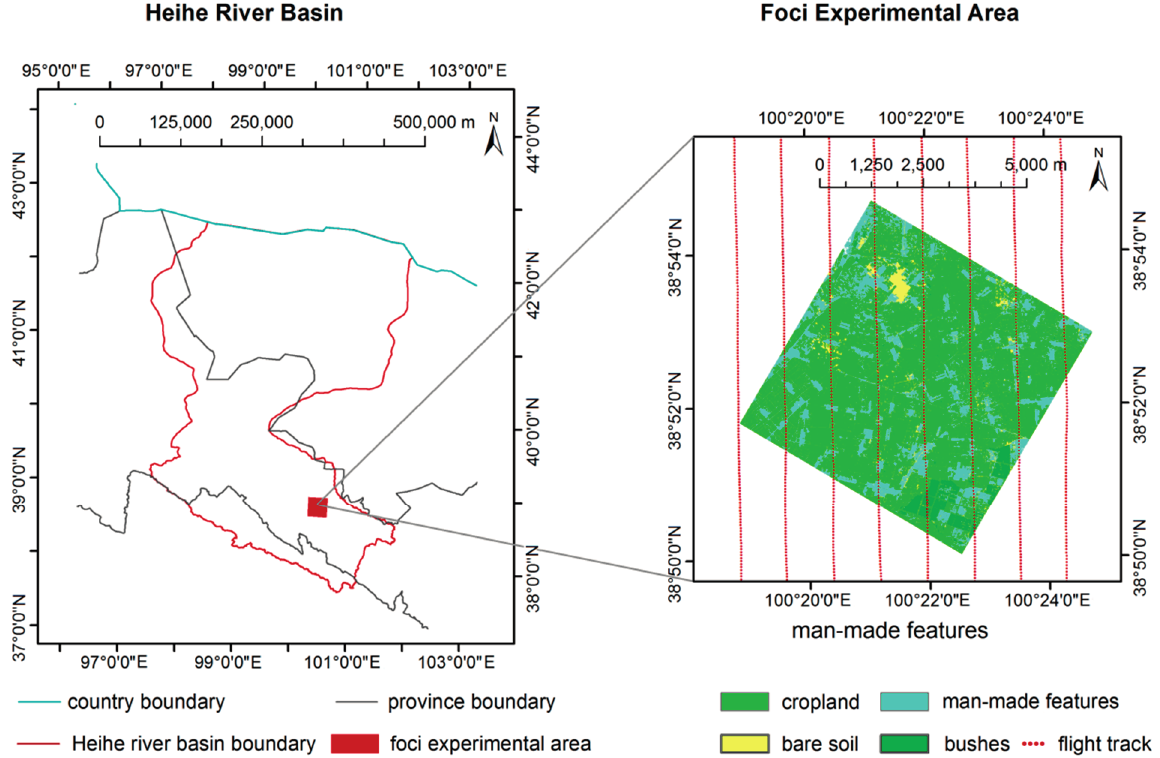
Figure 1. The Heihe River basin and foci experimental area, showing land classification and the flight track over the